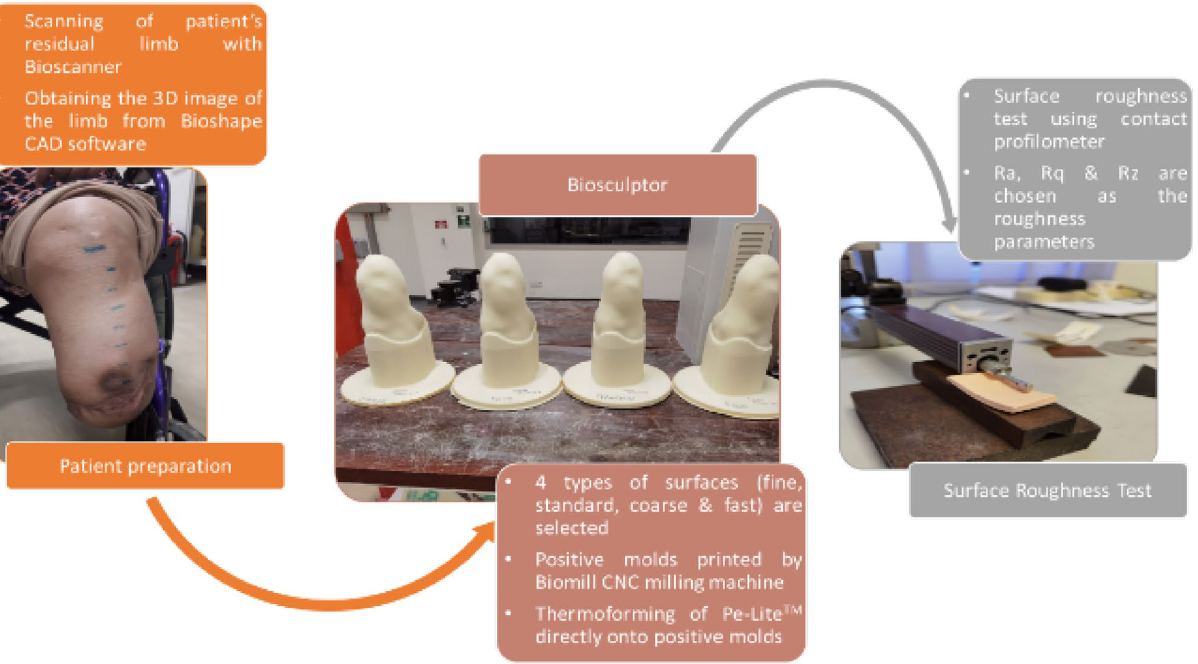
Figure 1. Diagram of the process of obtaining the four different types of surfaces of the Pe-Lite to be tested for surface roughness